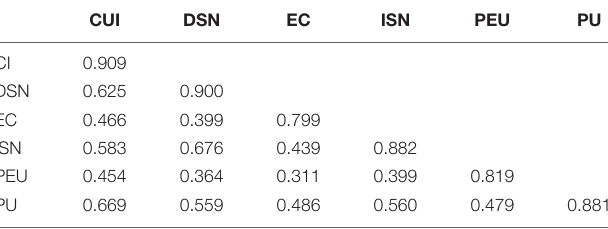
TABLE 4 | Fornell-Larcker discriminant validity.